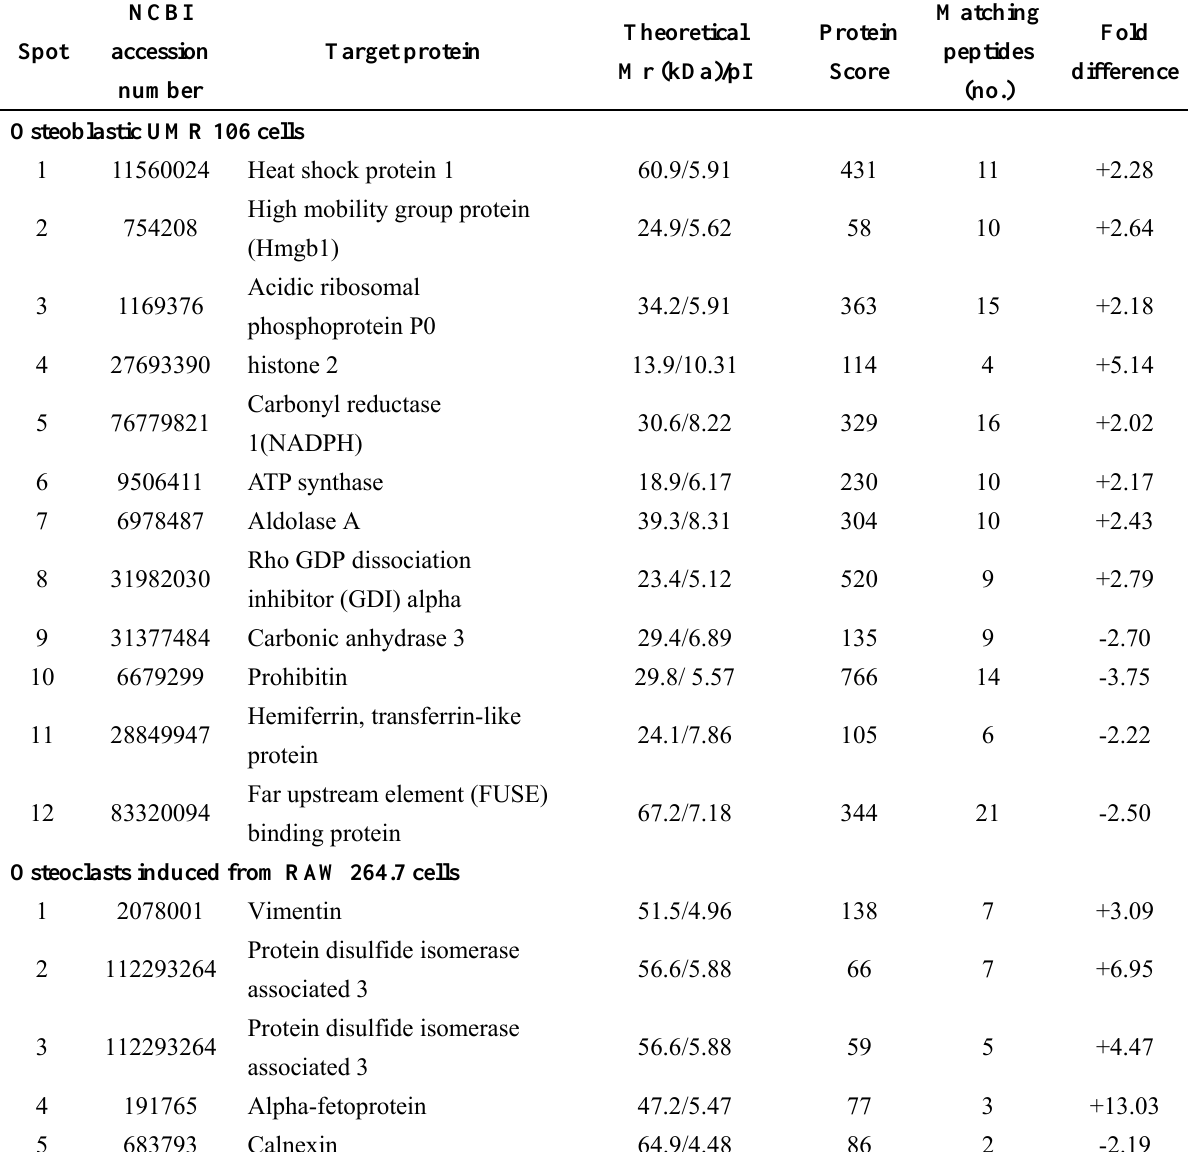
Table 1. The summary of differentially expressed proteins in osteoblastic UMR 106 cells and osteoclast induced from RAW264.7 cell treated with